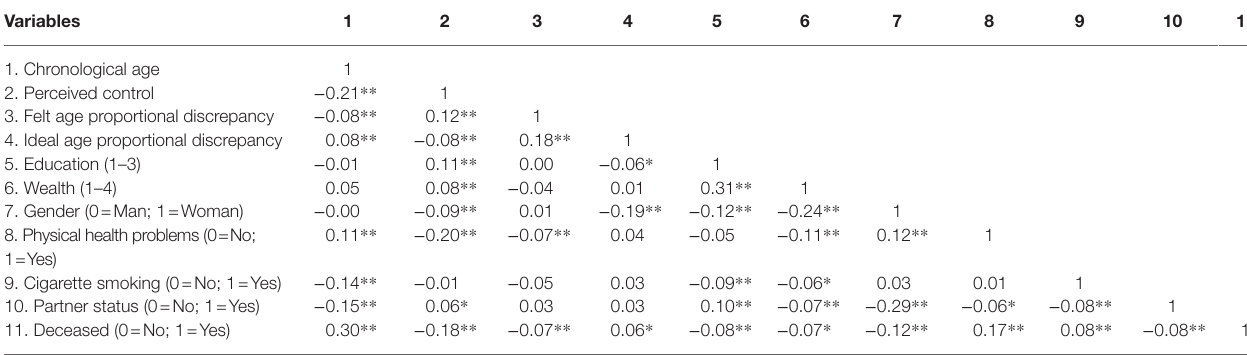
TABLE 2 | Bivariate correlations (Pearson’s r) between the study variables ( N = 1,432).